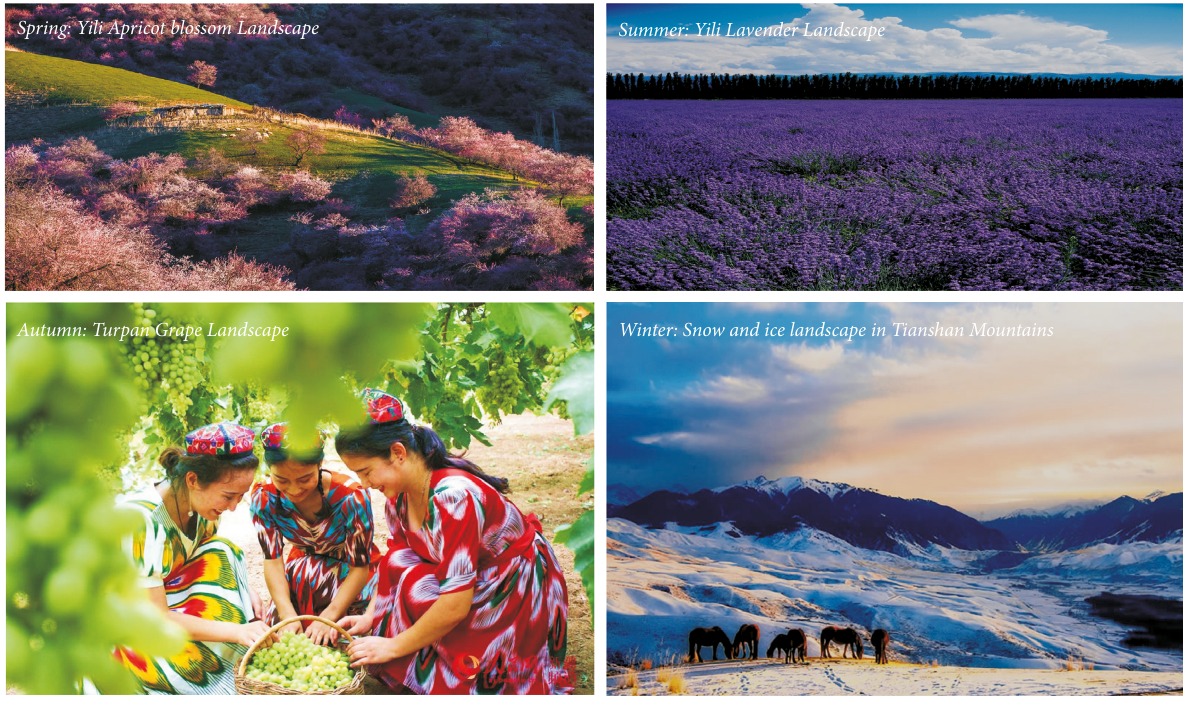
Figure 2: Seasonal tourism landscapes in four seasons.